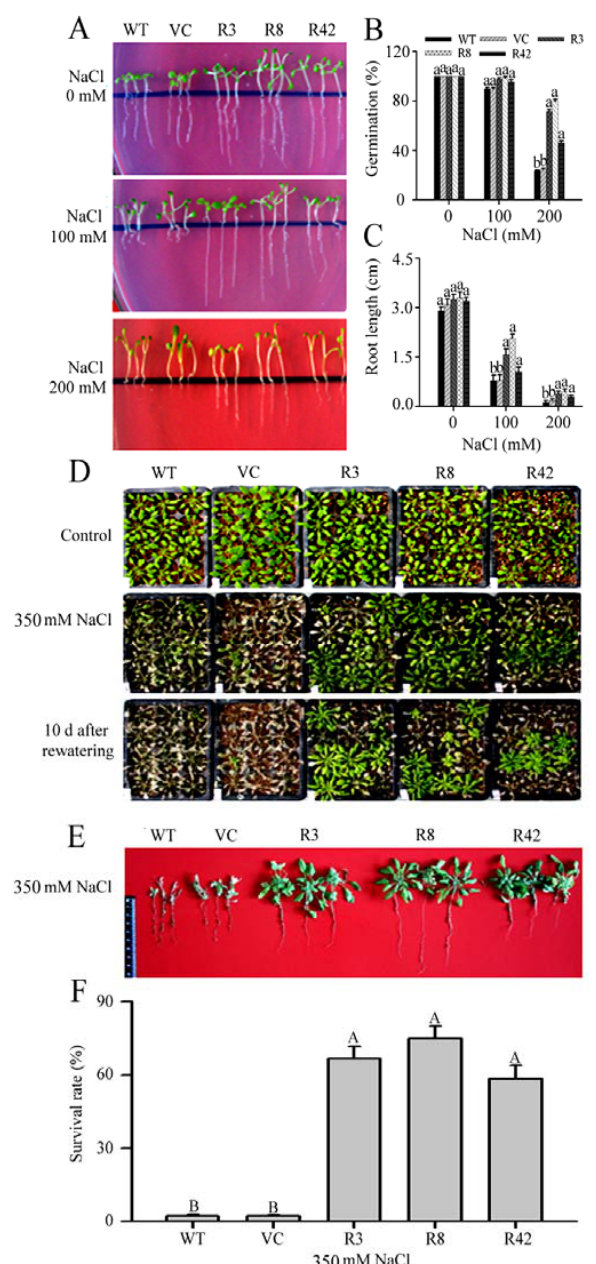
Figure 5. Comparison of wild-type and A. thaliana overexpressing MaROP5g under standard growing conditions (control) and different salt stress treatments. ( A ) Phenotypes of WT and transgenic lines under control and salt conditions; ( B ) Germination of WT and transgenic lines under control and salt conditions; ( C ) Root length of WT and transgenic lines under control and salt conditions; ( D , E ) Phenotypes of WT and transgenic mature plants under control or salt conditions or after rewatering; ( F ) Survival rates of WT and transgenic mature plants under control or salt conditions. WT: wild-type. VC: vector. R3, R8, R42: MaROP5g transgenic plants. ANOVA was used to compare the significance of differences, using Dunnett’s tests in the comparison between WT and each overexpression lines. Data are presented as means ± standard deviations of n = 3 biological replicates. Different lowercase letters above bars indicate significant differences at p < 0.05, different uppercase letters above bars indicate extremely significant differences at p < 0.01.